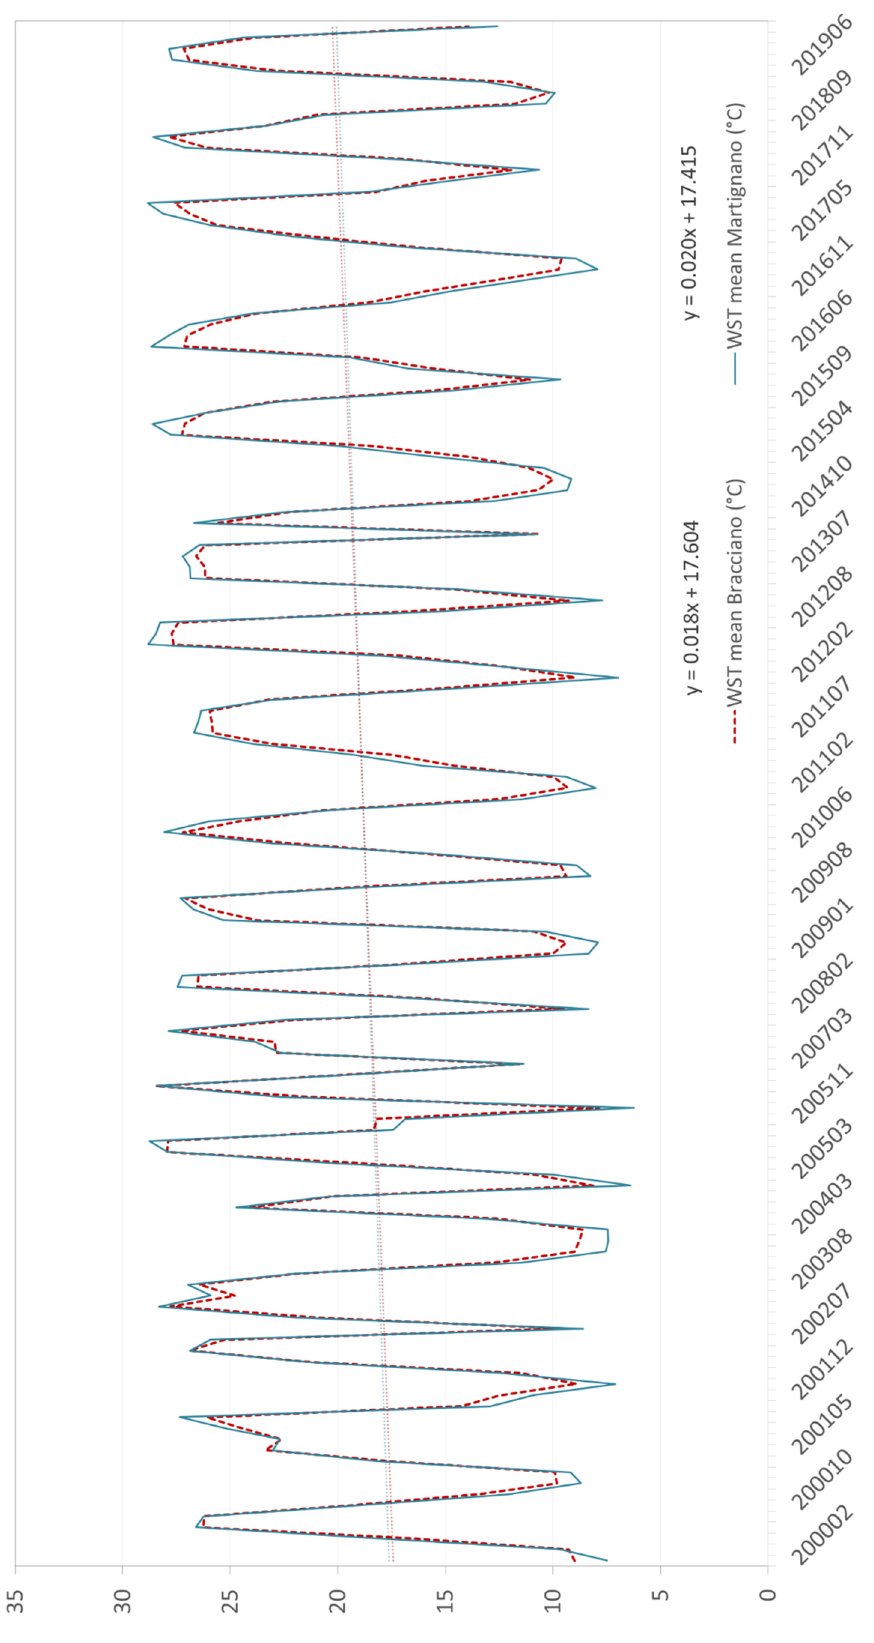
Figure 3. Monthly averaged WST derived from Landsat products with “method 1” from 2000 to 2019 for Lake Bracciano (red) and Lake Martignano (light blue).